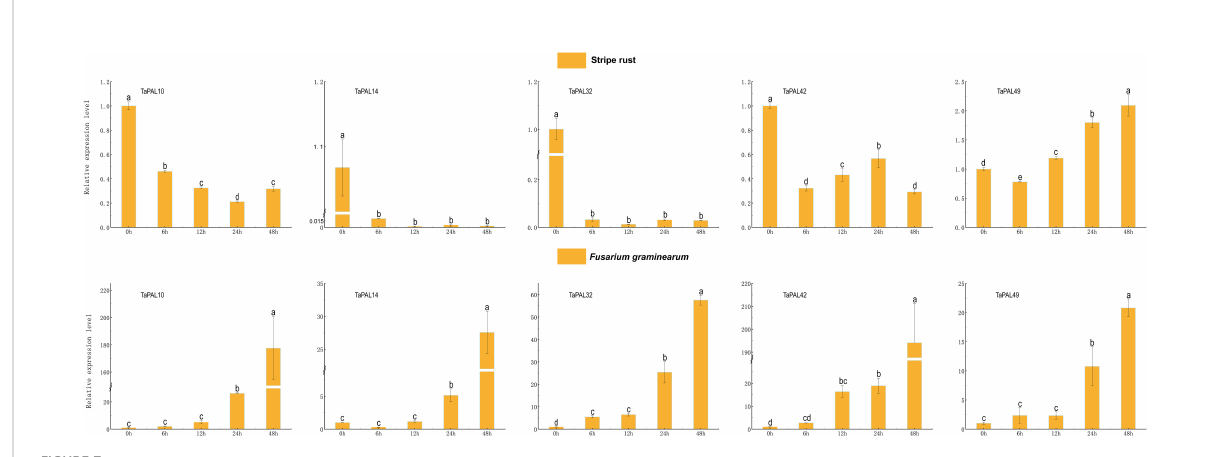
FIGURE 7 Reverse transcription quantitative PCR analysis of fi ve TaPAL genes under, F. graminearum , and P. striiformis treatment. Each bar represents the average of three replicates, and error bar represents standard deviation (SD). Different letters in a column indicate signi fi cant differences between the treatments at p < 0.05